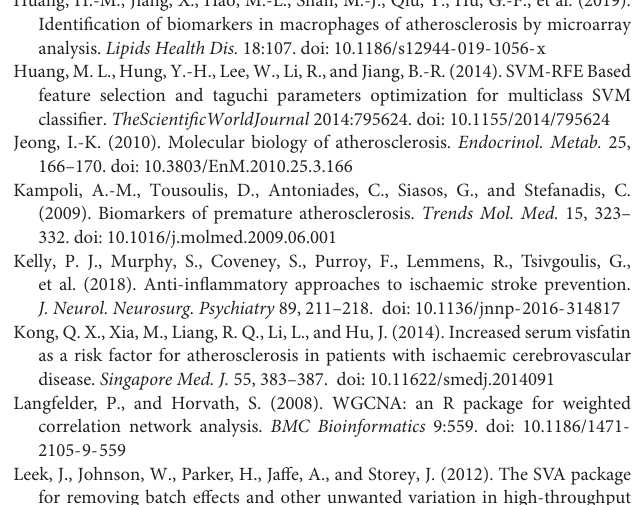
Supplementary Figure 1 | Dendrogram of clustering of all AS samples in the merge dataset.